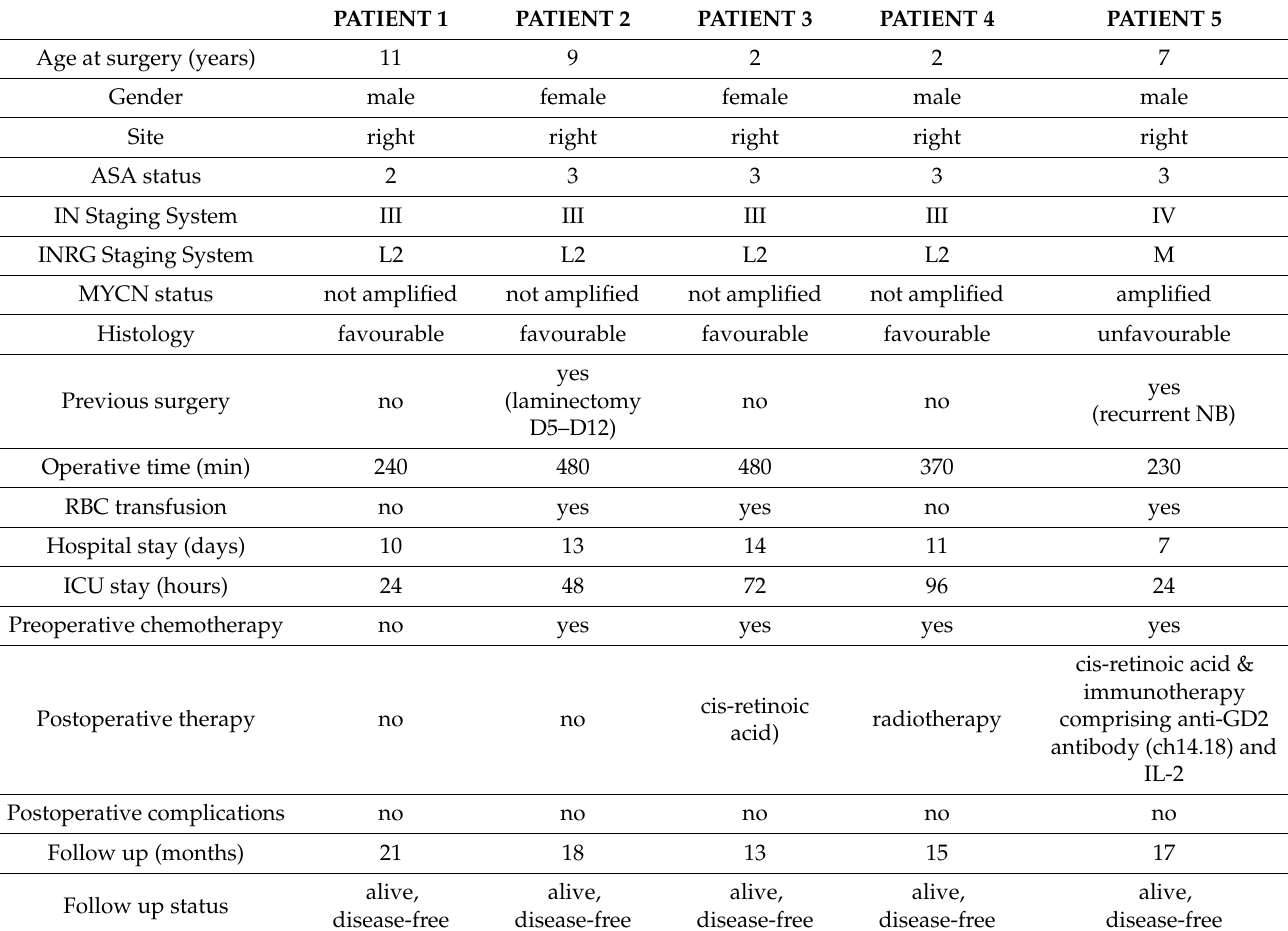
Table 1. Patient demographic and tumour